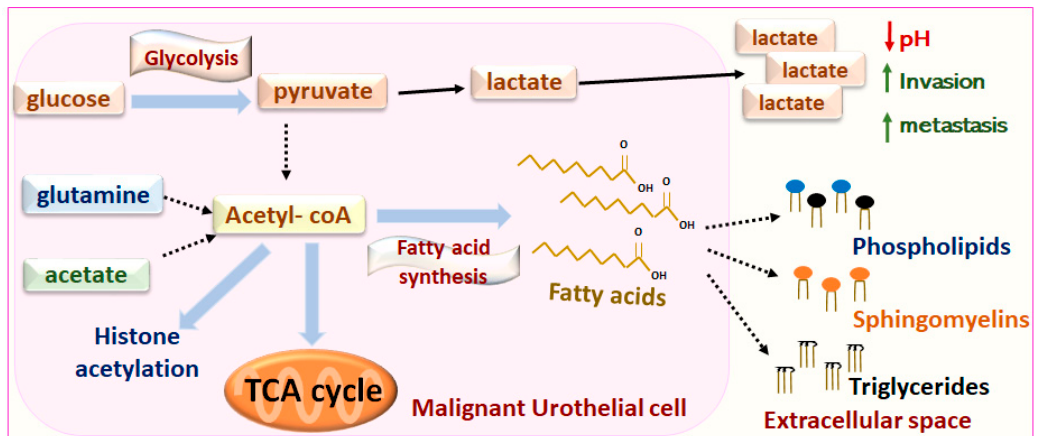
Figure 4. Metabolic reprogramming of tumor cells. Tumor cells convert glucose to lactate through aerobic glycolysis, even if sufficient oxygen levels are present. Lactate is then secreted to the extracellular space, acidifying the tumor microenvironment and favoring tumor invasion and metastasis. Tumor cells exhibit increased fatty acid production through acetyl-coA either from glucose, glutamine or acetate catabolism. Fatty acids are used to synthesize triglycerides, phospholipids and sphingomyelins. Acetyl-coA fuels the TCA cycle and contributes to epigenetic modifications through histone acetylation. Acetyl-coA: Acetyl- coenzyme A, TCA: Tricarboxylic